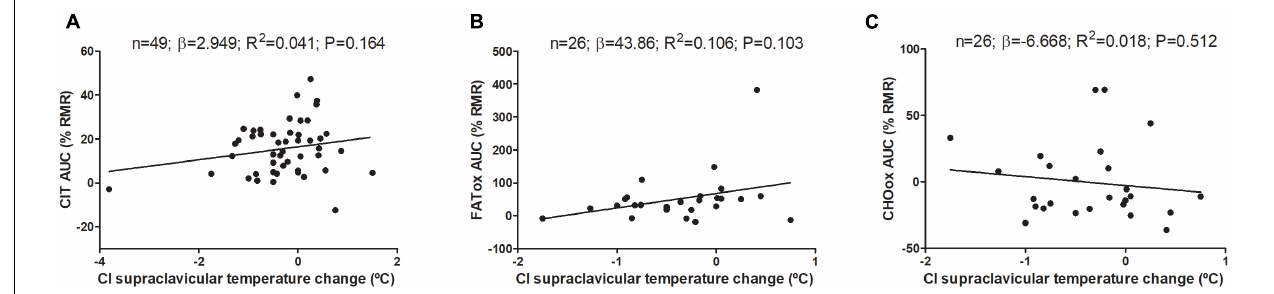
FIGURE 3 | Association of cold-induced (CI) supraclavicular skin temperature change with cold induced thermogenesis (CIT) and cold-induced nutrient oxidation rates (including participants of studies 1 and 2). Unstandardized simple regression coefficient ( β ) and standardized coefficient of determination (R 2 ). AUC: Area under the curve; RMR: resting metabolic